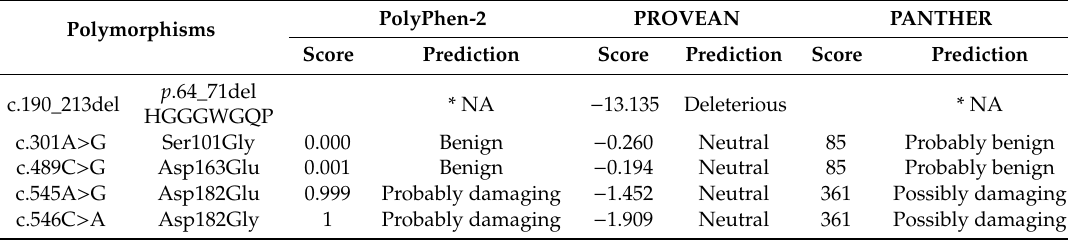
Table 5. In silico analysis of nonsynonymous SNPs of the PRNP gene in